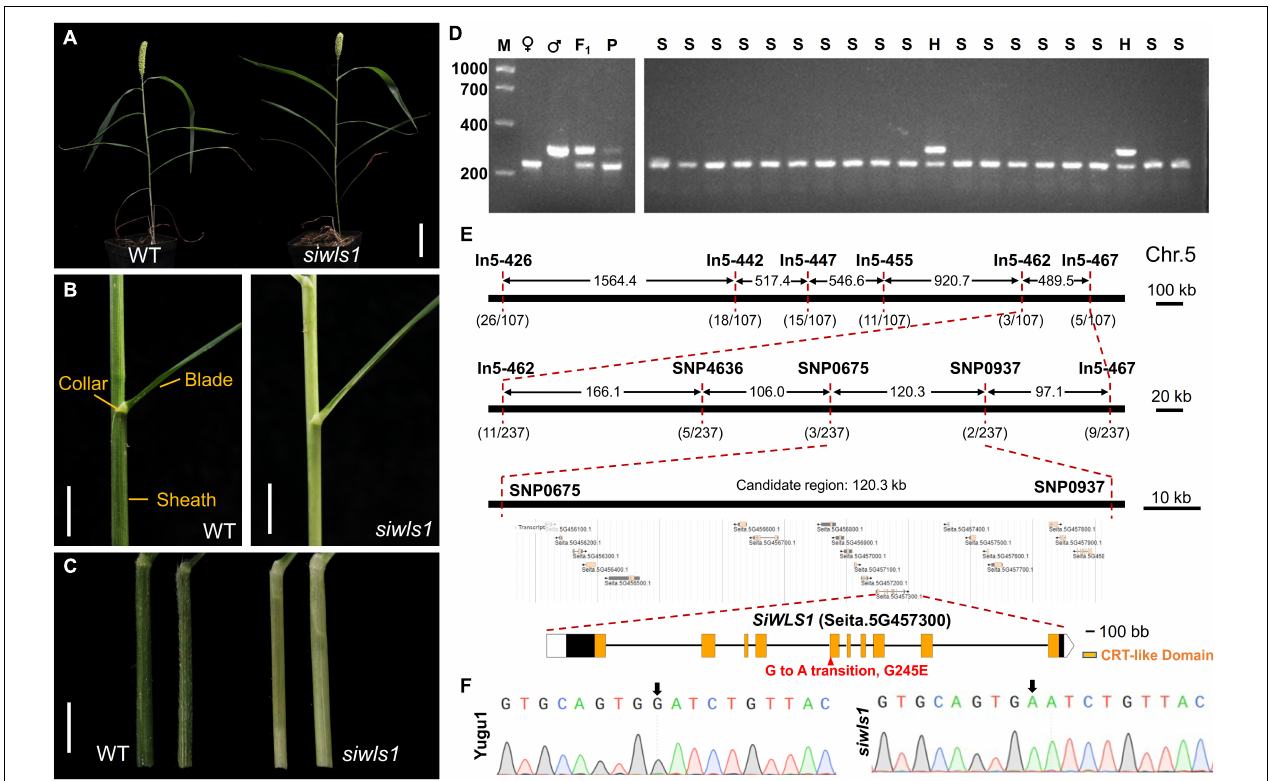
FIGURE 5 | Characterization of foxtail millet white leaf sheath mutant siwls1 and identification of the candidate gene. (A) General statures of siwls1 mutant and wild-type plants at maturity. Bar = 5 cm. (B) Leaf blade, leaf collar, and leaf sheath morphology of “Yugu1” (WT) and siwls1 . Bar = 1 cm. (C) An enlarged view of leaf sheath of wild-type and mutant plants. Bar = 1 cm. (D) An example of a molecular marker “In5-455” closely linked to the SiWLS1 locus. M, DL 2000 molecular weight marker; , PCR product amplified from female parent siwls1 ; , PCR product amplified from male parent SSR41; F 1 , PCR product amplified from F 1 individual; P, PCR product amplified from the DNA pool of a mixture of 30 recessive homozygous individuals in F 2 population; S, PCR product amplified from ♀ ♂ recessive homozygous individual in F 2 population; H, PCR product amplified from heterozygous individual in F 2 population. (E) Positional cloning of SiWLS1 using newly developed molecular markers. (F) Sanger sequencing validation of the causal